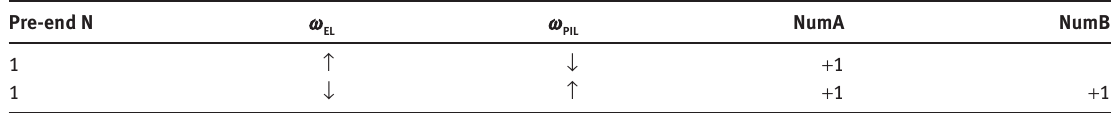
Table 3: Weight Alteration for